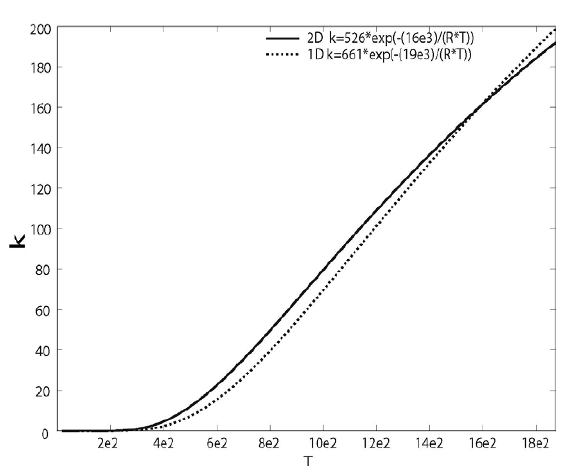
Figure 4. Comparison of dependence of diffusion coefficients on the temperature in one- and two-dimensional models.